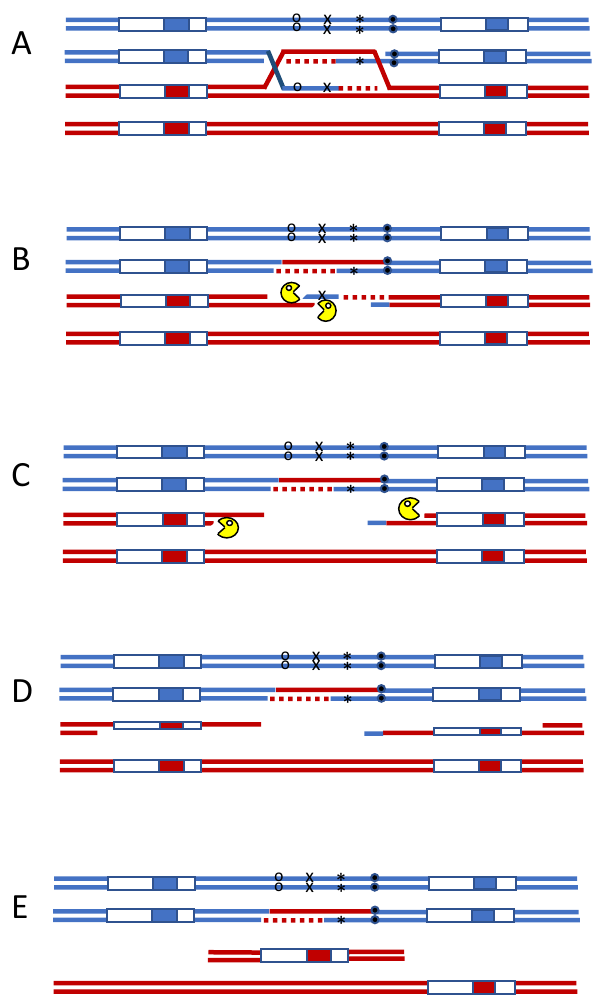
Figure 1. Mismatch repair initiates secondary DSBs during meiotic recombination. Heteroduplex DNA formed during meiotic recombination. ( A ) can be attacked by two independent mismatch repair complexes, oriented on opposite strands ( B ). Exonuclease-dependent removal of adjacent DNA can lead to secondary DSBs ( C ). When the region is flanked by repeated sequences, single-strand annealing (SSA) will result in the deletion of the intervening DNA ( D , E